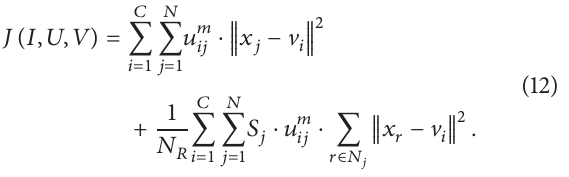
Figure 1: 2D square window. (a) The central pixel is noisy. (b) The central pixel is not